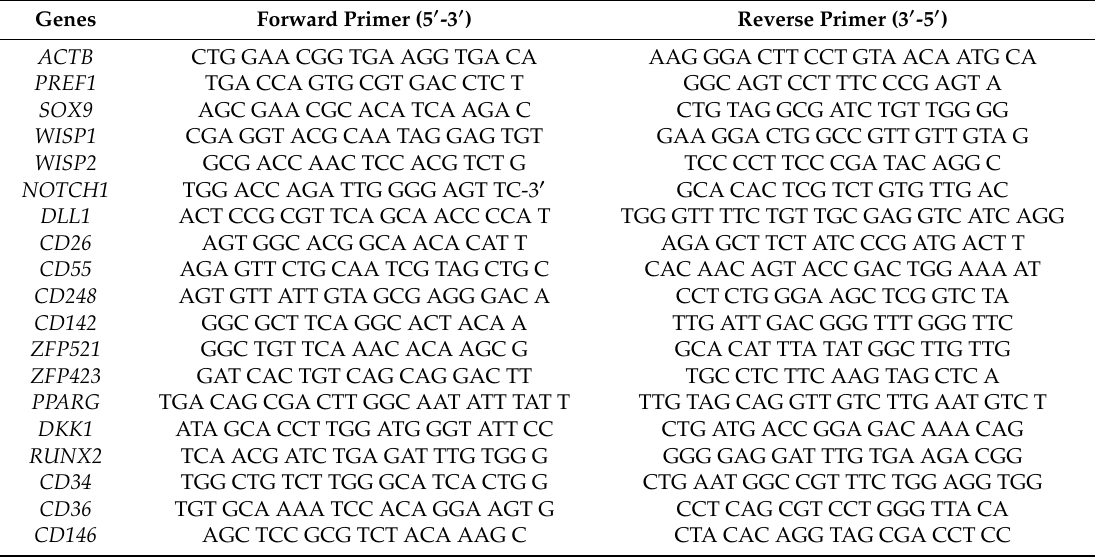
Table 1. Overview of primer sequences used for RT-qPCR